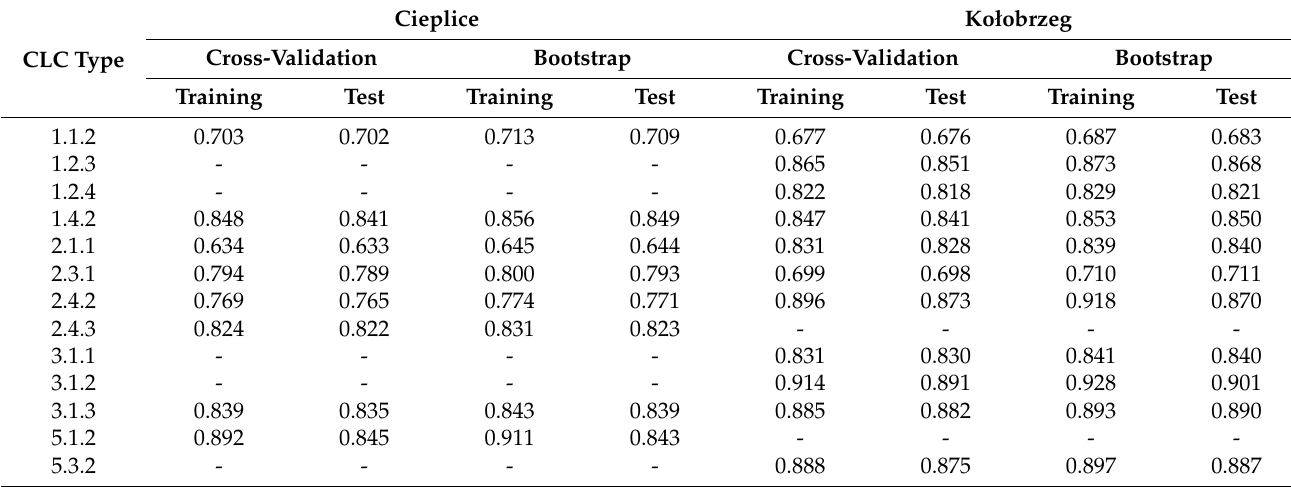
Table A3. Validated averages of AUC values for Cieplice and Kołobrzeg using cross-validation and bootstrapping methods.